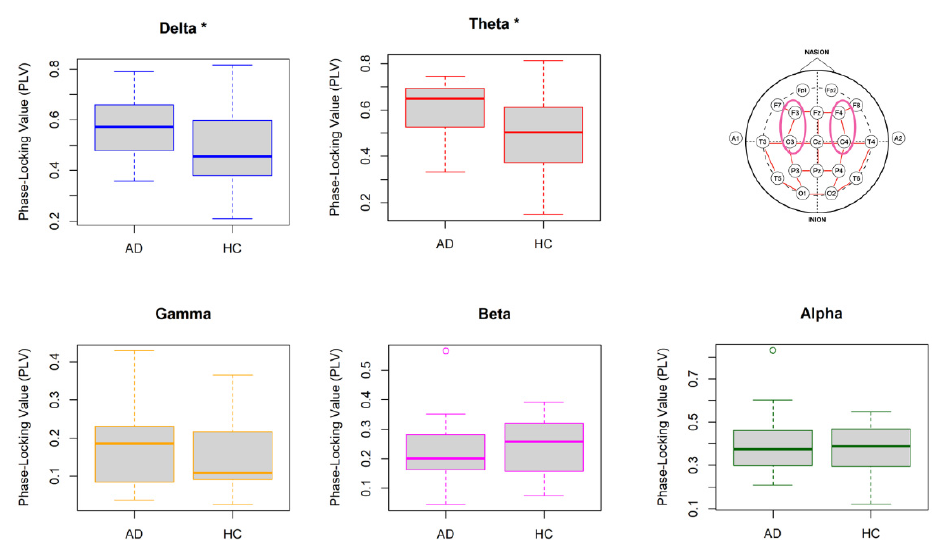
Figure 5. The PLVs obtained from the homotopic pair in the fronto-central region (Pair B). Plots marked with * indicate a statistically significant difference ( p < 0.05) between AD patients and HCs.